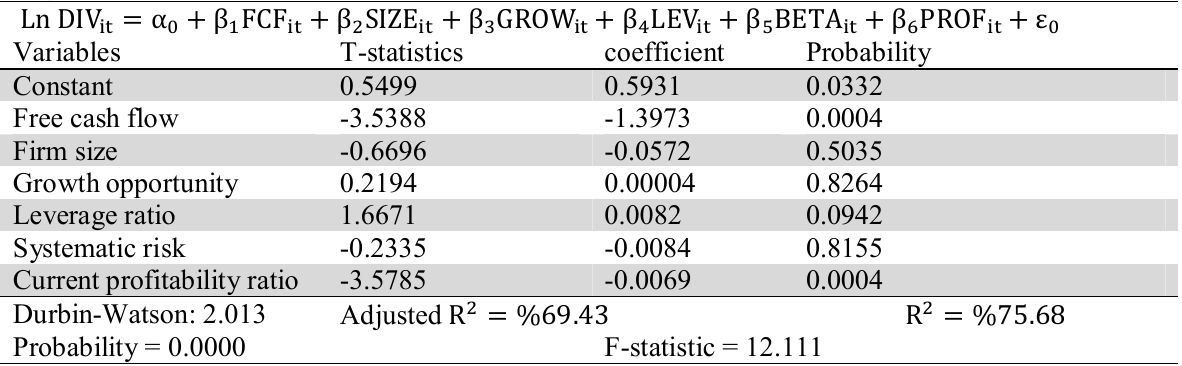
Hypothesis analysis